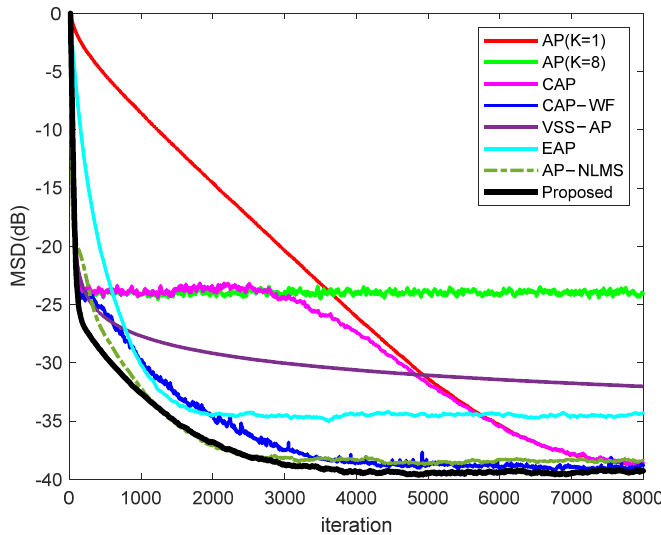
Figure 6. Convergence curves of the proposed algorithm and the conventional AP, CAP, CAP − WF, VSS − AP, EAP, and AP − NLMS algorithms in a stationary environment with SNR = 30 dB.